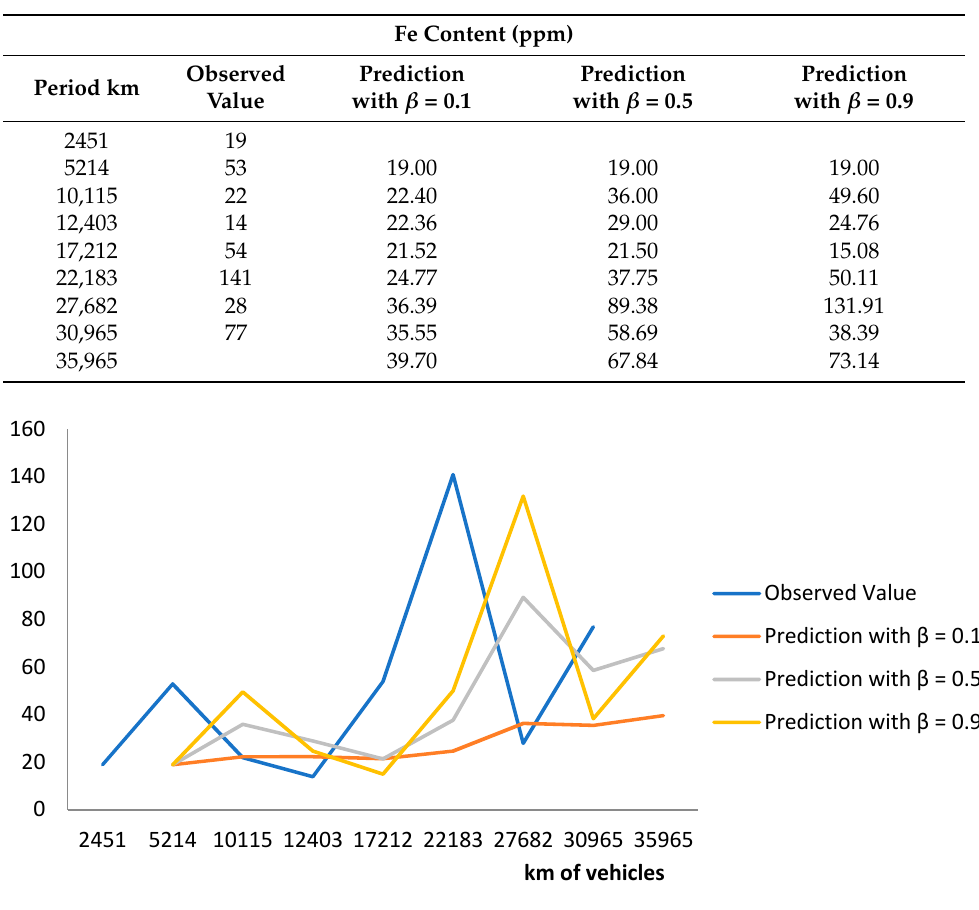
Figure 3. Graph of exponential smoothing – Fe (ppm) content.